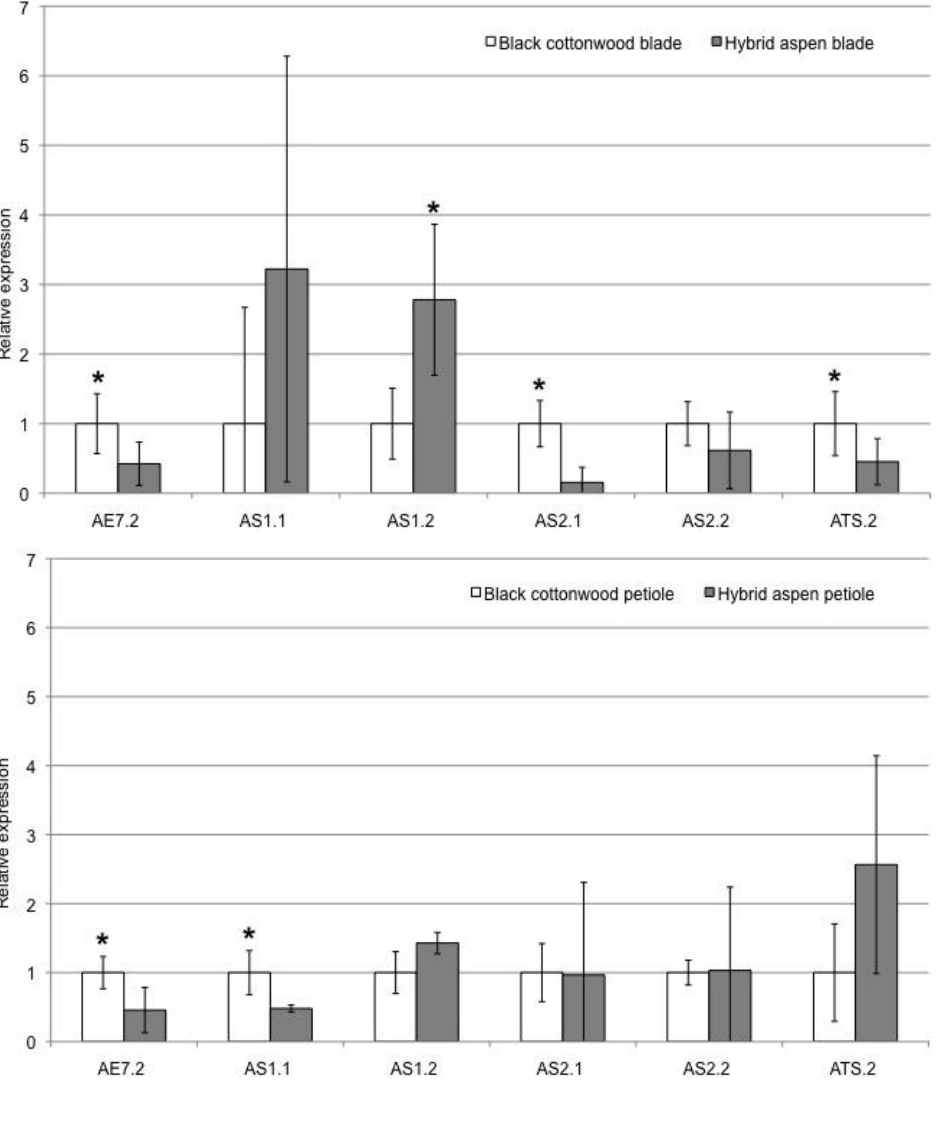
Figure 3. qRT-PCR results comparing black cottonwood and aspen leaf blade (top) and petiole (bottom) tissues. Asterisks indicate the genes that show a significant difference in expression between the two species, with the asterisk above the gene in the species that has higher expression. White bars show relative expression in black cottonwood, while grey bars show relative expression in aspen. Error bars indicate variability observed across biological and technical